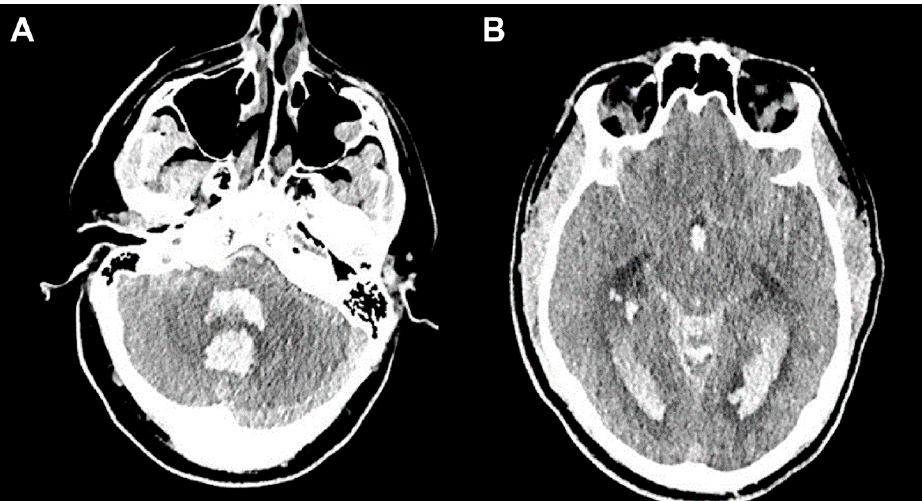
Figure 3. Case 1: Head Computed Tomography. ( A ) Cerebellar hemorrhage and adjacent markedly dilated fourth ventricle with intraventricular hemorrhage (IVH). ( B ) Bilateral lateral and posterior ventricular system IVH with dilated temporal and lateral ventricles consistent with acute hydro ‐ cephalus.